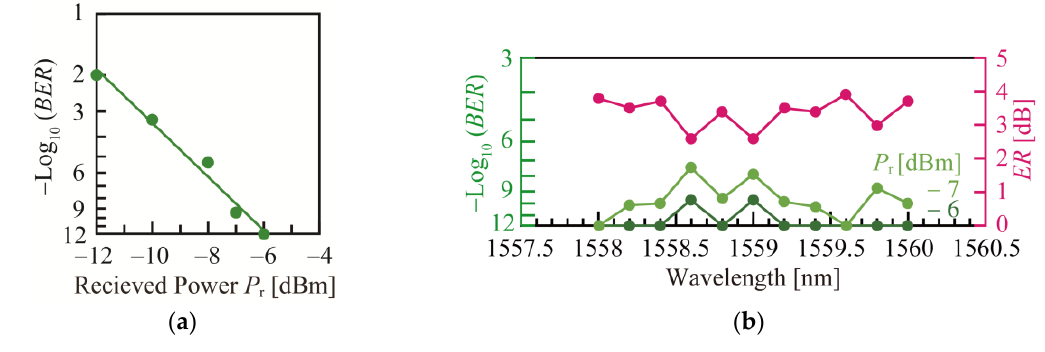
Figure 7. BER characteristics at 25 Gbps for 2 7 − 1 bit NRZ-PRBS signals: ( a ) BER at λ = 1559.6 nm; ( b ) BER and ER at λ = 1558–1560 nm.